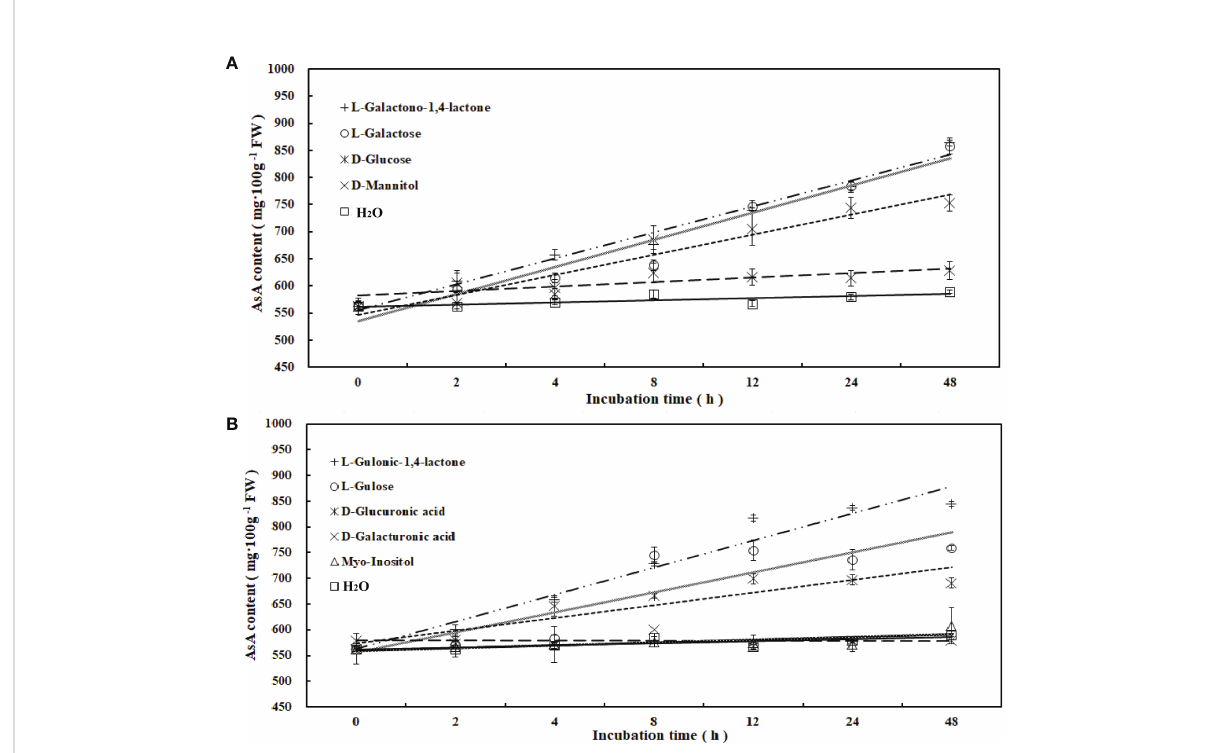
FIGURE 2 Changes of AsA content during incubation of AsA biosynthetic candidate precursors. AsA content changes following incubation of fruit fl esh at 70 DAA with candidate precursors of AsA biosynthesis, at a concentrations of 15 mM. (A, B) included 4 and 5 candidate precursors, respectively, and water was used as a